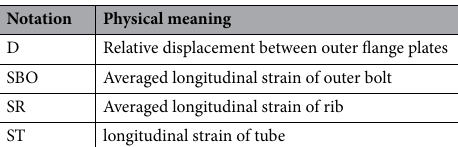
Table 2. Physical meaning of capital letters in reference numbers of measuring points.